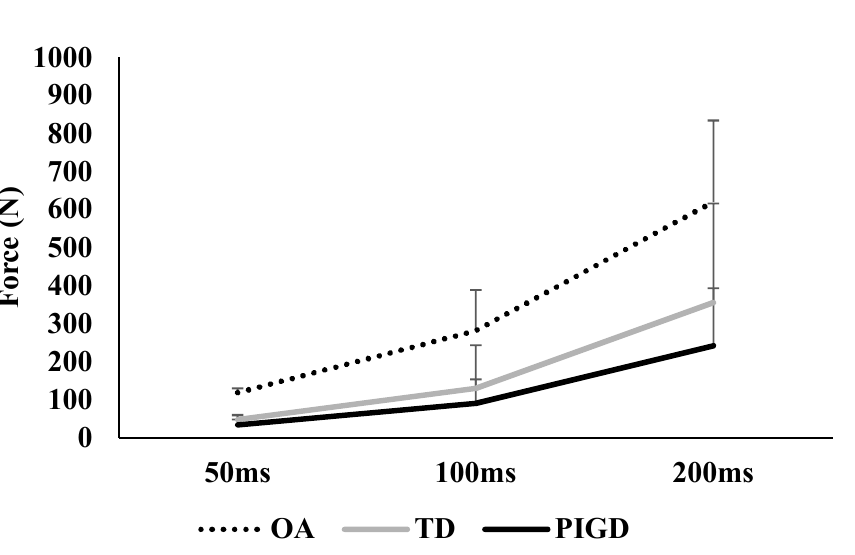
Figure 1. Force production comparisons between the OA, TD, and PIGD groups. Data are mean (SD). OA: older adults; TD: tremor-dominant group; PIGD: postural instability and gait difficulty group; RFD: rate of force development. * p < 0.05 and ** p < 0.001.